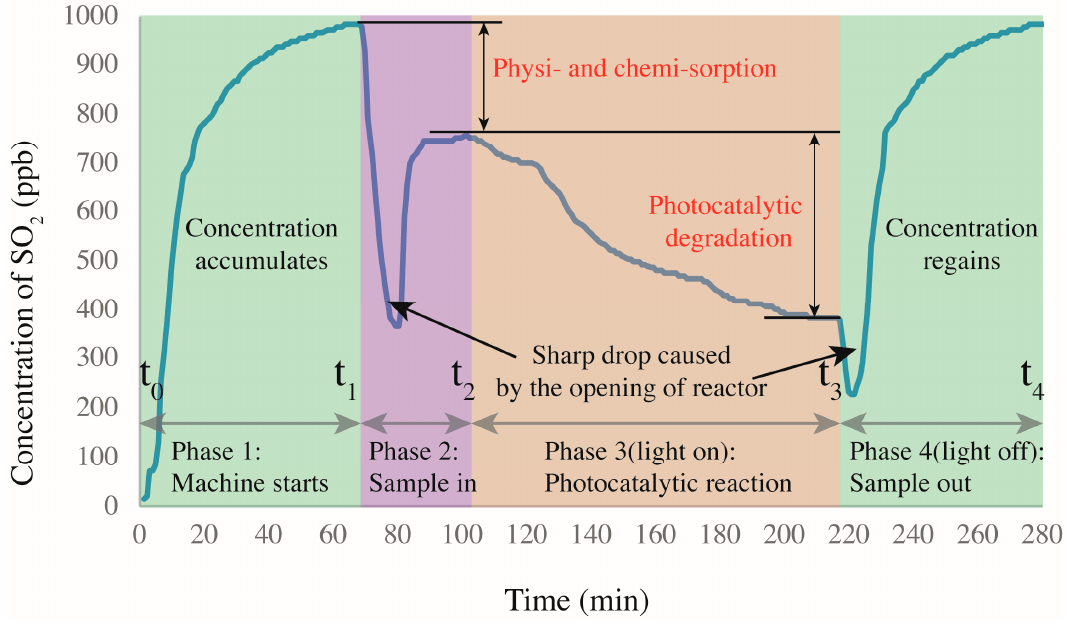
Figure 6. SO 2 degradation in presence of CP-incorporated specimen: the whole degradation process.